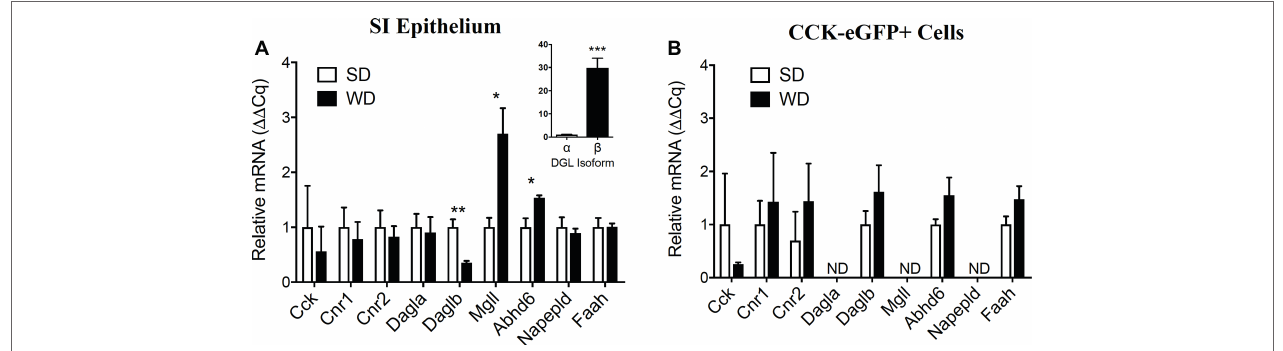
FIGURE 5 | Expression of select components of the eCB system is dysregulated in the upper small intestine of DIO mice and partially conserved in CCK-eGFP+ cells. Expression of mRNA for cholecystokinin (Cck), cannabinoid receptor subtype 1 (Cnr1) and 2 (Cnr2), and other components of the eCB system in upper small-intestinal mucosal scrapings are not impacted by western diet (WD) exposure when compared to controls fed a standard diet (SD) (A) . Expression of diacylglycerol lipase beta (Daglb) is decreased, and expression of the degradative enzymes monoacylglycerol lipase (Mgll) and alpha-beta hydrolyzing domain 6 (Abhd6) are increased in WD mice. Expression of mRNA for CCK or components of the eCB system were not significantly affected by diet in eGFP (+) sorted cells (B) . Expression of mRNA for diacylglycerol lipase alpha (Dagla), Mgll, and N-acyl phosphatidylethanolamine specific phospholipase D (Napepld) was not detected (ND) (B) . Data expressed as mean ± S.E.M. Analyzed using Student’s two-tailed t -test. n = 3 per group in triplicate and * p < 0.05, ** p < 0.01, *** p < 0.001 (A) ; n = 3 per group in triplicate, p > 0.05 (B)